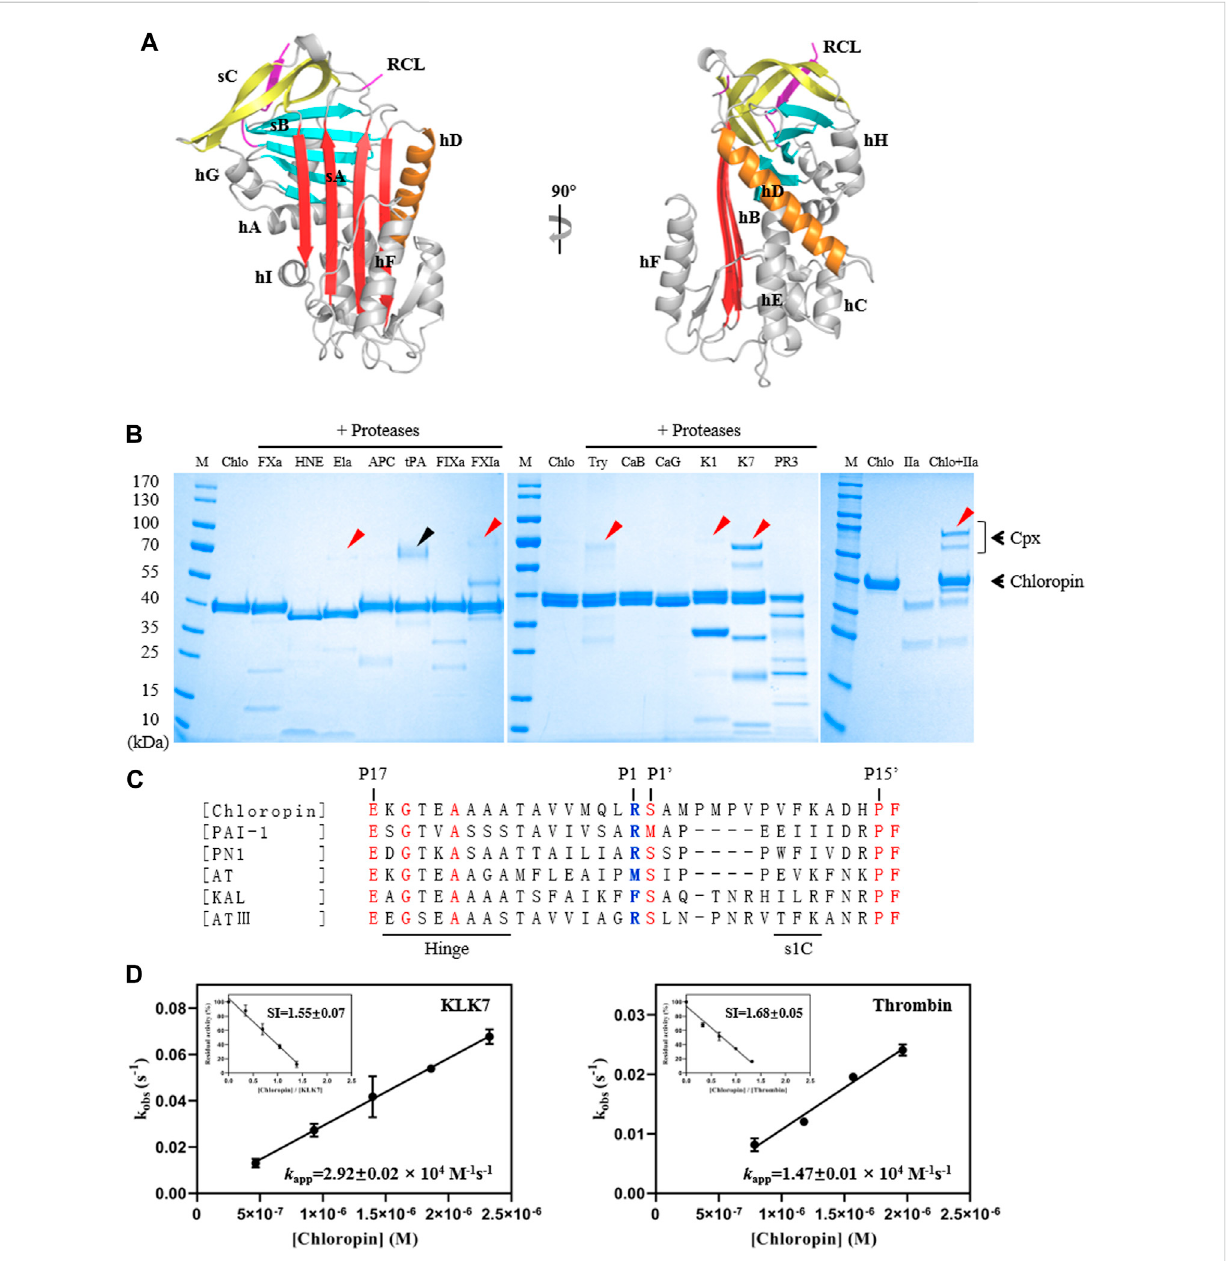
FIGURE 1 Structure and activity analysis of chloropin. (A) The crystal structure of chloropin contains 9 α -helices (hA-I), 3 β -sheets (A – C), and areaction center loop (RCL). Part of the RCL was not resolved in the structure due to its fl exibility which is a common feature in many serpins. (B) 3 μ g chloropin was incubated with 0.4 μ g proteases including activated factor X (FXa), human neutrophil elastase (HNE), pancreatic elastase (Ela), activated protein C (APC), tissue-type plasminogen activator (tPA), activated factor IX (FIXa), activated factor XI (FXIa), trypsin (Try), cathepsin B (CaB) cathepsin G (CaG), kallikrein 1 (K1), kallikrein 7 (K7), proteinase 3 (PR3) and thrombin (IIa) respectively at 37 ° C for 30 min and the complex formation was then analyzed by SDS-PAGE. The red arrows are used to indicate the chloropin-protenase covalent complexes (Cpx), and the ~70 kDa band in the tPA lane is the protease itself(markedbyablackarrow). (C) AlignmentofRCLsequencesofchloropin(UniprotB3ECZ8)withotherheparin-bindinginhibitoryserpinssuchasPAI- 1 (Uniprot P05121), protease nexin 1 (Uniprot P07093), antitrypsin (Uniprot A0A024R6I7), kallistatin (Uniprot P29622) and antithrombin (Uniprot P05154). The conserved amino acids are shown in red and the active center P1 is shown in blue. (D) Determination of the stoichiometry of inhibition (SI) and association rate constants ( k app ) of chloropin ’ s inhibition of KLK7 (left panel) and thrombin (right